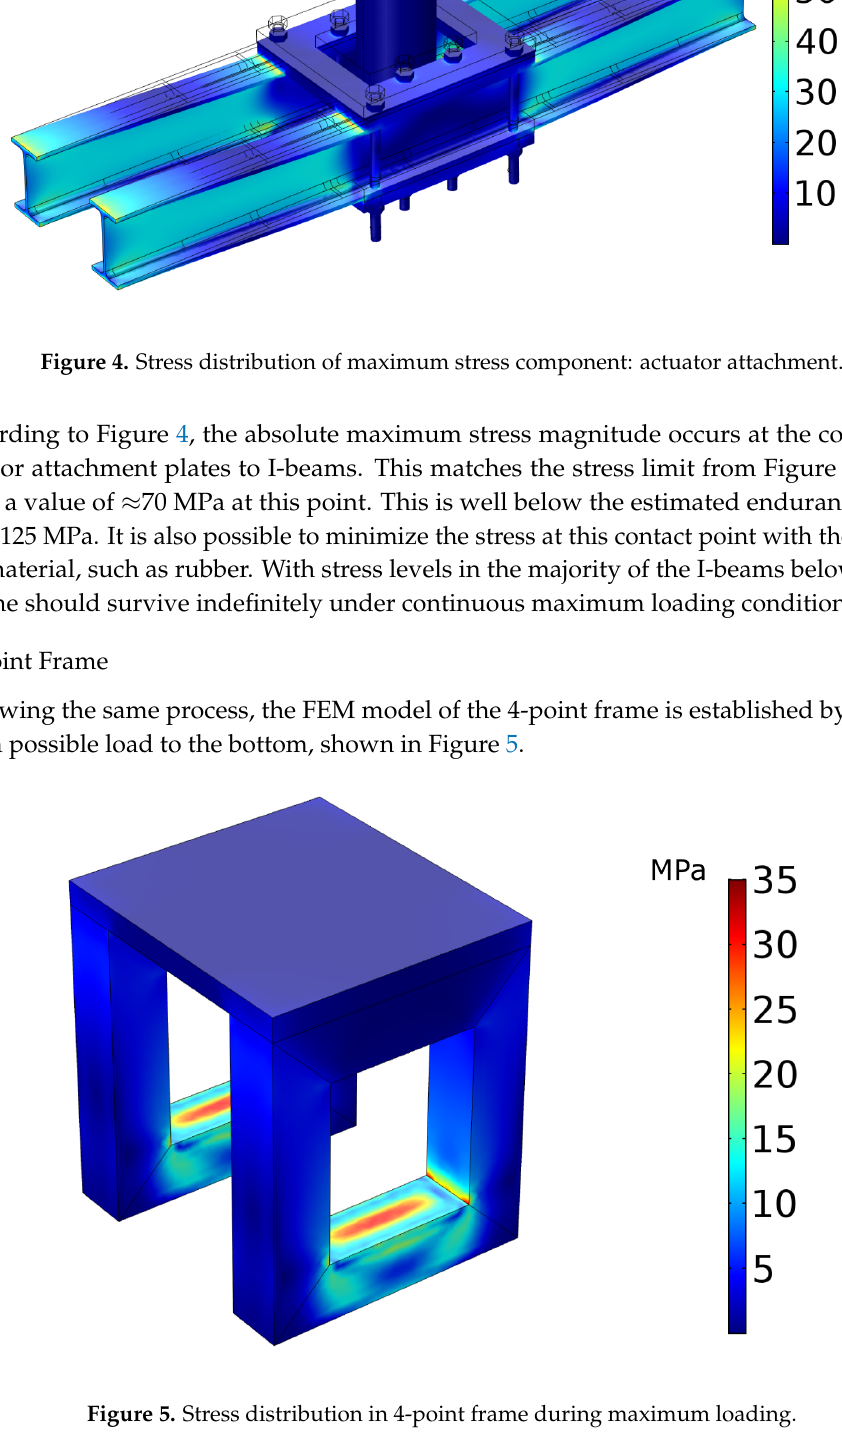
Figure 5. Stress distribution in 4-point frame during maximum